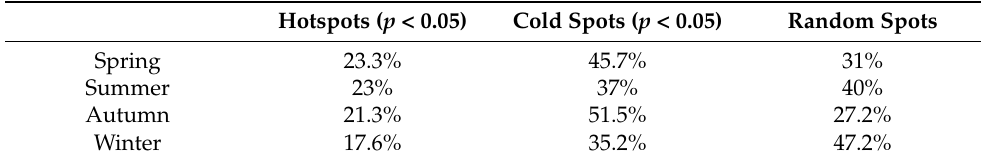
Table 1. The number of each category and their proportion to the total grids. Hotspots ( p < 0.05) Cold Spots ( p < 0.05) Random Spots Spring 23.3% 45.7% 31% Summer 23% 37% 40% Autumn 21.3% 51.5% 27.2% Winter 17.6% 35.2%